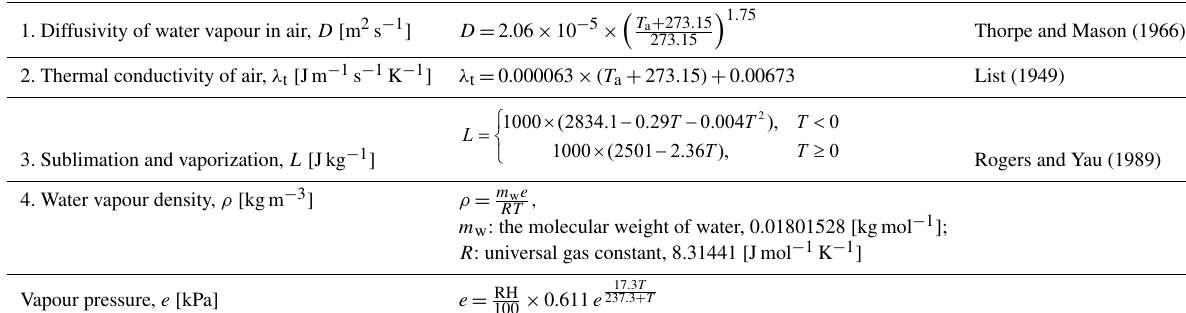
Table 2. Additional formulas for Eq.